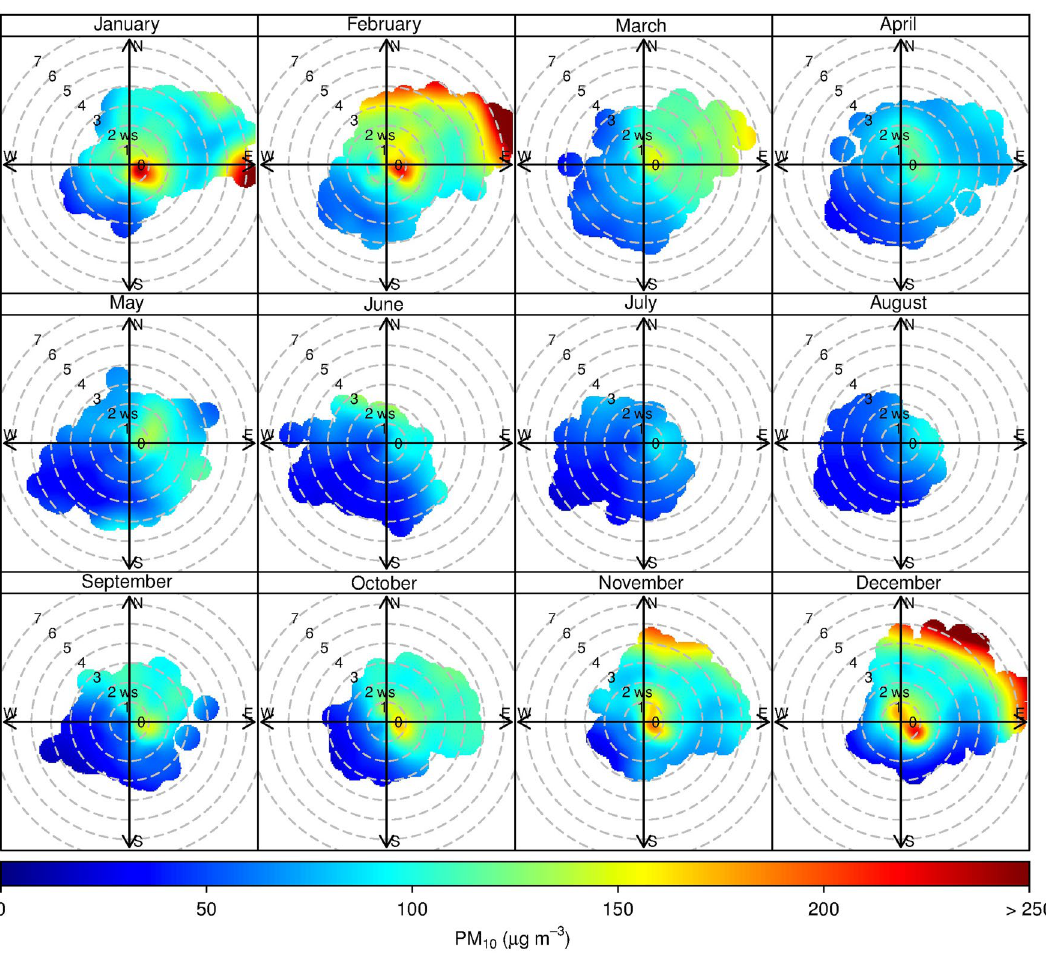
Figure 6. Bivariate polar plot of the mean PM 10